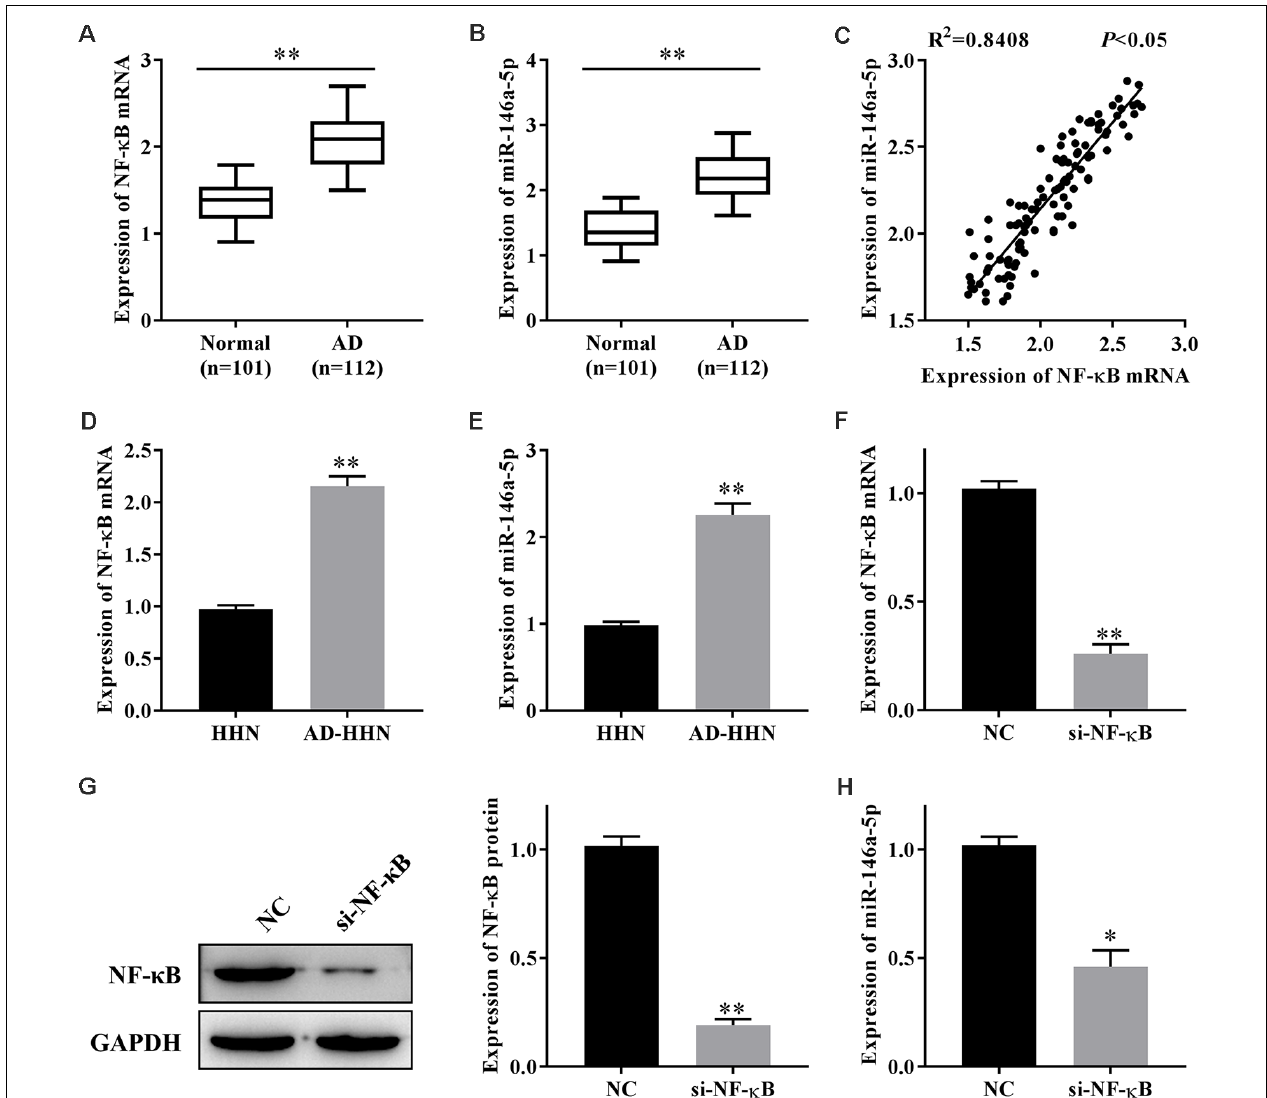
FIGURE 1 | The expression of nuclear factor kappa β (NF- κ B) is correlated with that of miR-146a-5p in patients with Alzheimer’s disease (AD) and a cell culture model of AD in human hippocampal neurons (AD-HNNs). (A) Relative expression level of NF- κ B mRNA. ∗∗ P < 0.01 vs. normal group. (B) Relative expression level of miR-146a-5p. ∗∗ P < 0.01 vs. normal group. (C) Linear analysis between NF- κ B mRNA and miR-146a-5p. (D) NF- κ B mRNA in AD-HNNs. ∗∗ P < 0.01 vs. HHN group. (E) NF- κ B protein in AD-HNNs. ∗∗ P < 0.01 vs. HHN group. (F) Transfection efficiency of si-NF- κ B into AD-HNNs. ∗∗ P < 0.01 vs. NC group. (G) Expression of NF- κ B protein after si-NF- κ B transfection into AD-HNNs. ∗∗ P < 0.01 vs. NC group. (H) Expression of miR-146a-5p after si-NF- κ B transfection into AD-HNNs. ∗ P < 0.05 vs. NC